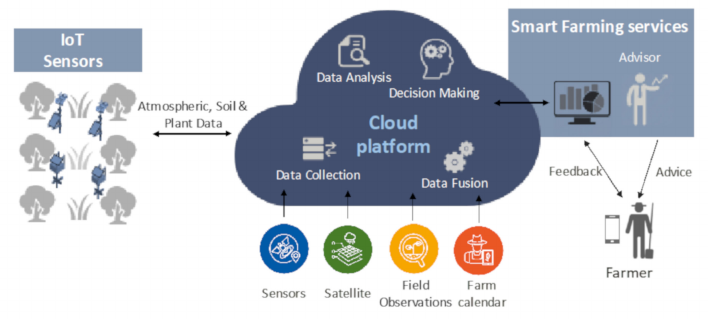
Figure 2. Information flow for the Smart Farming as a Service